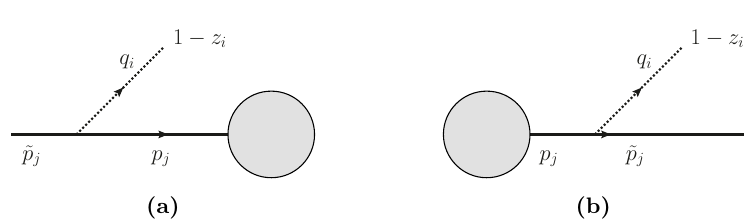
Figure 2. De(cid:12)ning the kinematics: (a) q i is emitted o(cid:11) an incoming leg; (b) q i is emitted o(cid:11) an outgoing